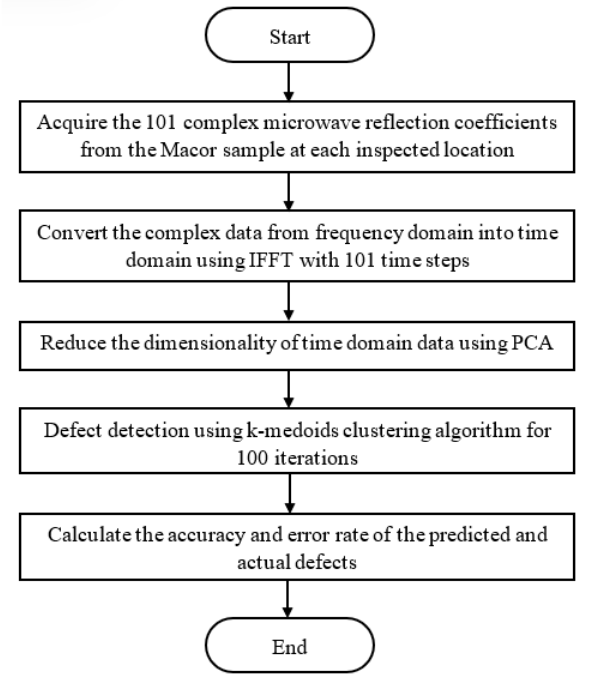
Figure 7. Work frame of microwave NDT with k-medoids clustering algorithm for defect detection and size estimation.